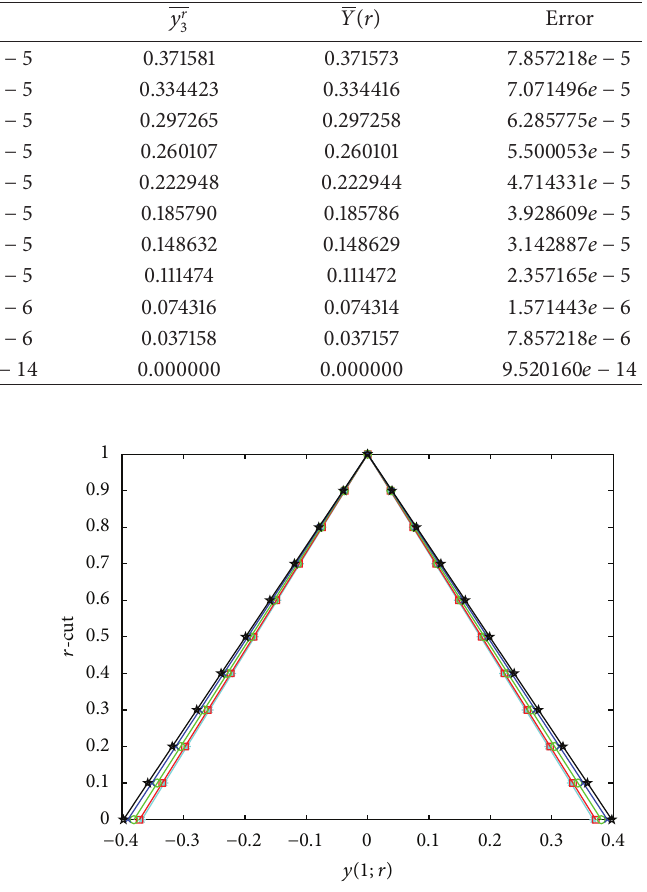
Figure 12: The fuzzy approximate solution for different 𝛼 :(1:star,